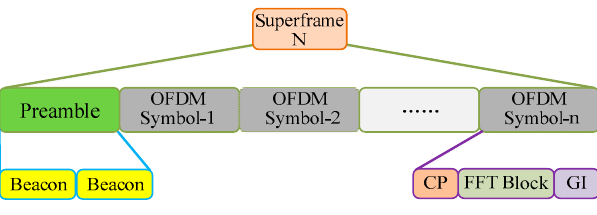
Figure 2. Superframe structure.